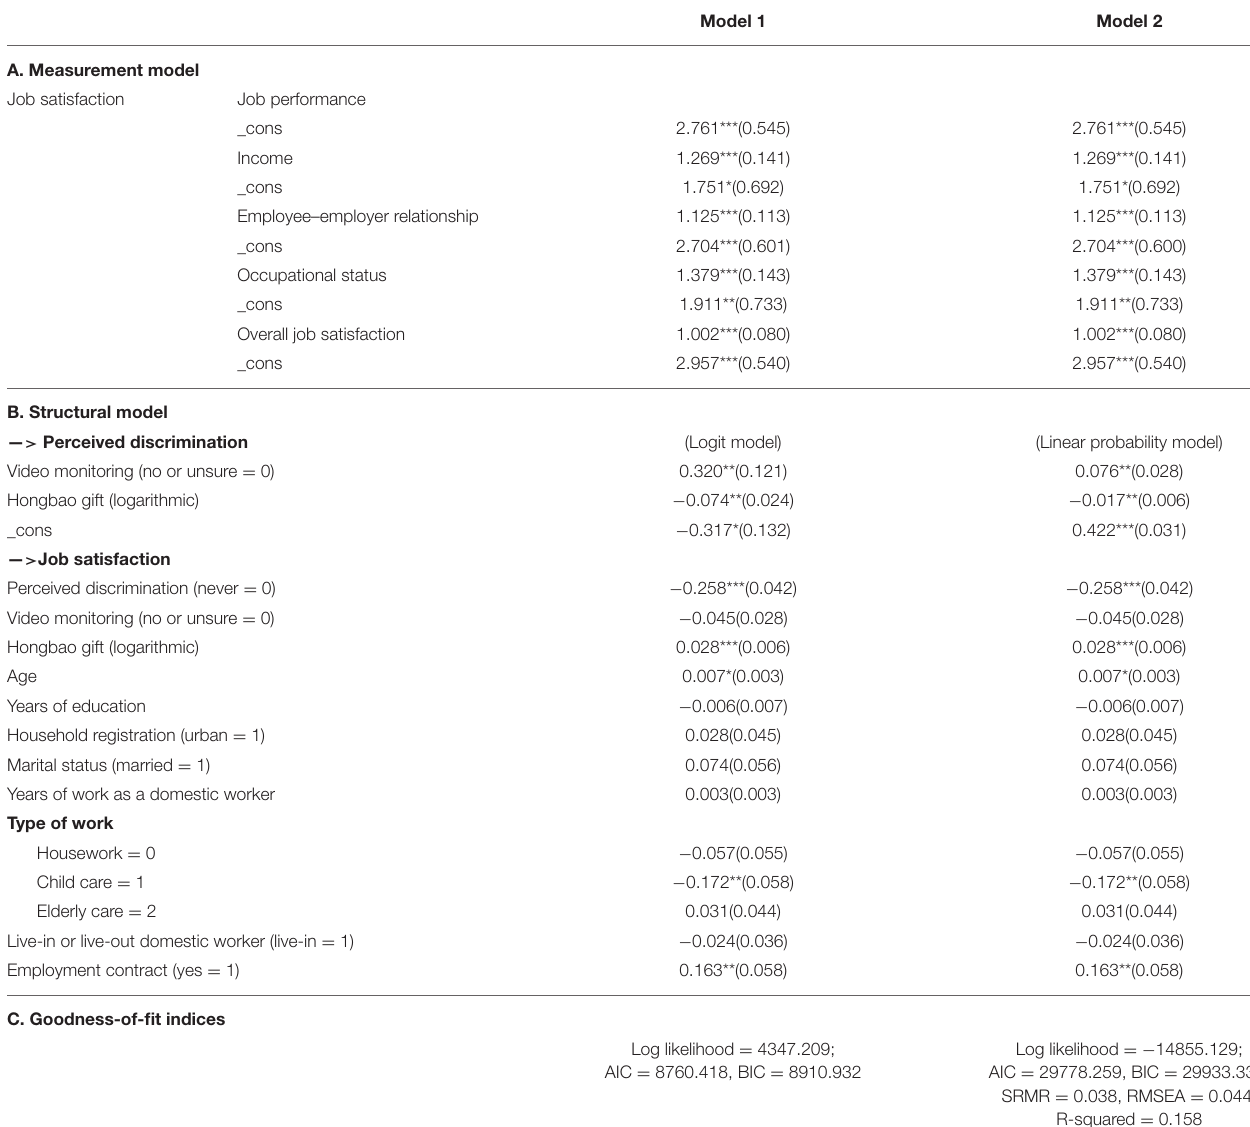
TABLE 2 | Results of SEM analysis for domestic workers’ job